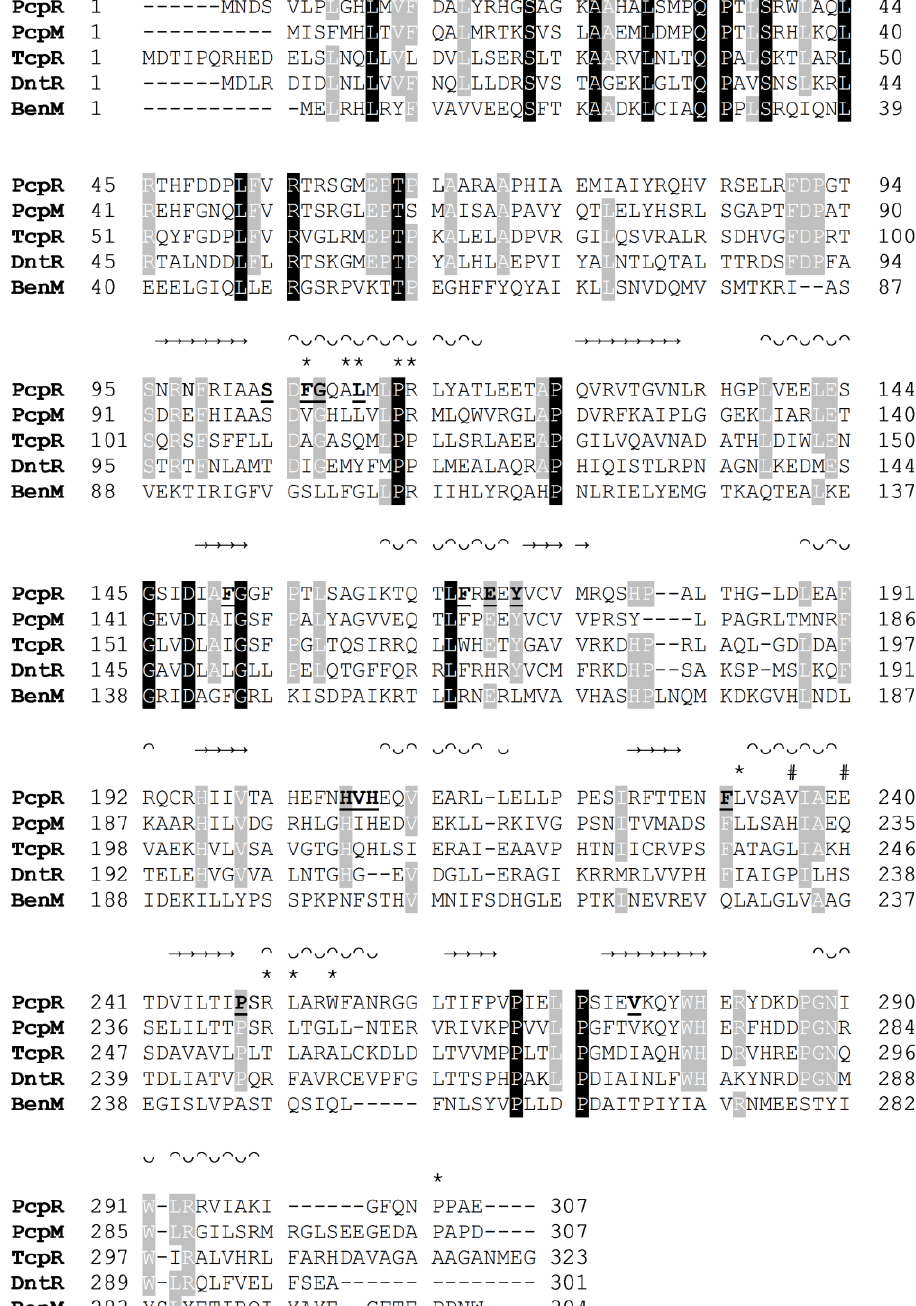
Figure 6. Multiple sequence alignment of PcpR, PcpM, TcpR, DntR and BenM. β-strands are signified with → and helices with ᴖᴗ. IBC1 interacting residues are marked with bolded and underlined residue symbol. IBC2 interacting residues are marked with an * . IBC2 interacting residues at the dimer interface are marked with #. Multiple sequence alignment was performed with CLUSTALW